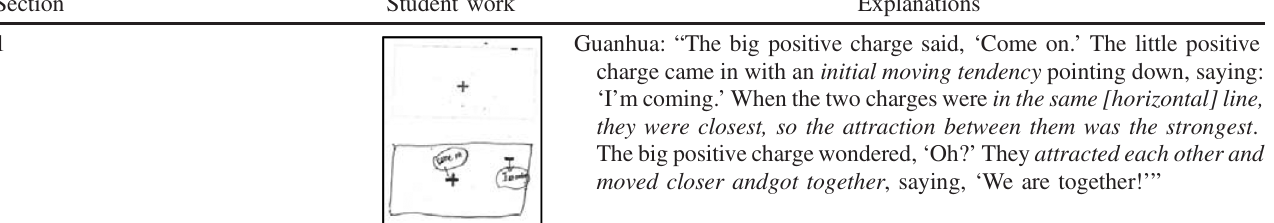
TABLE V. Guanhua ’ s work.